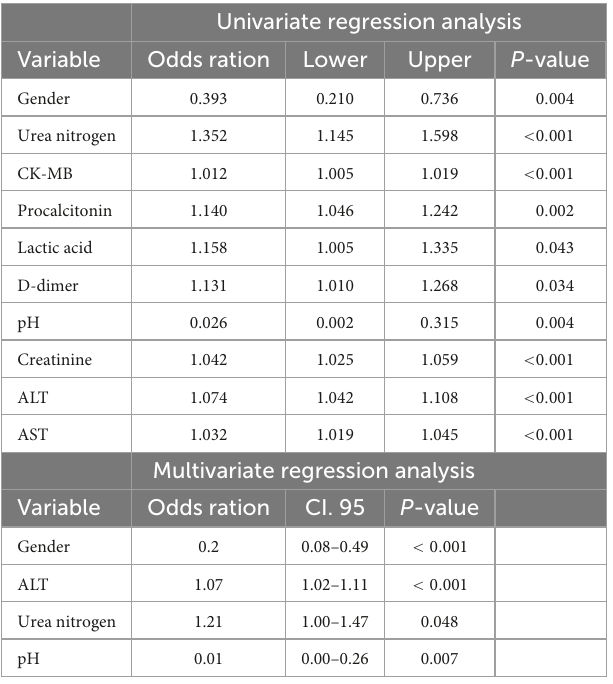
TABLE 3 Positive results of univariate and multivariate regression analysis between control and HIE groups. Univariate regression analysis